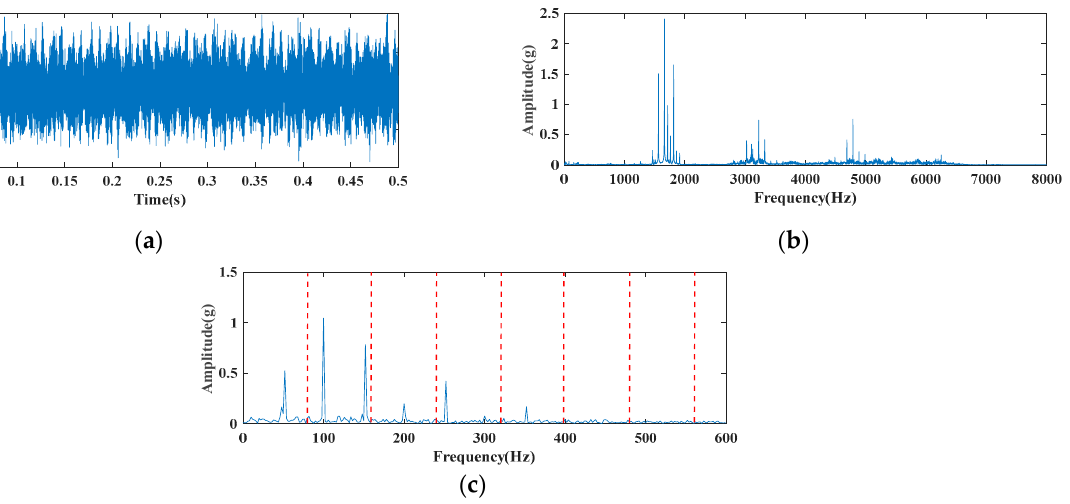
Figure 24. Engineering fault signal: ( a ) waveform; ( b ) frequency spectrum; ( c ) envelope spectrum.